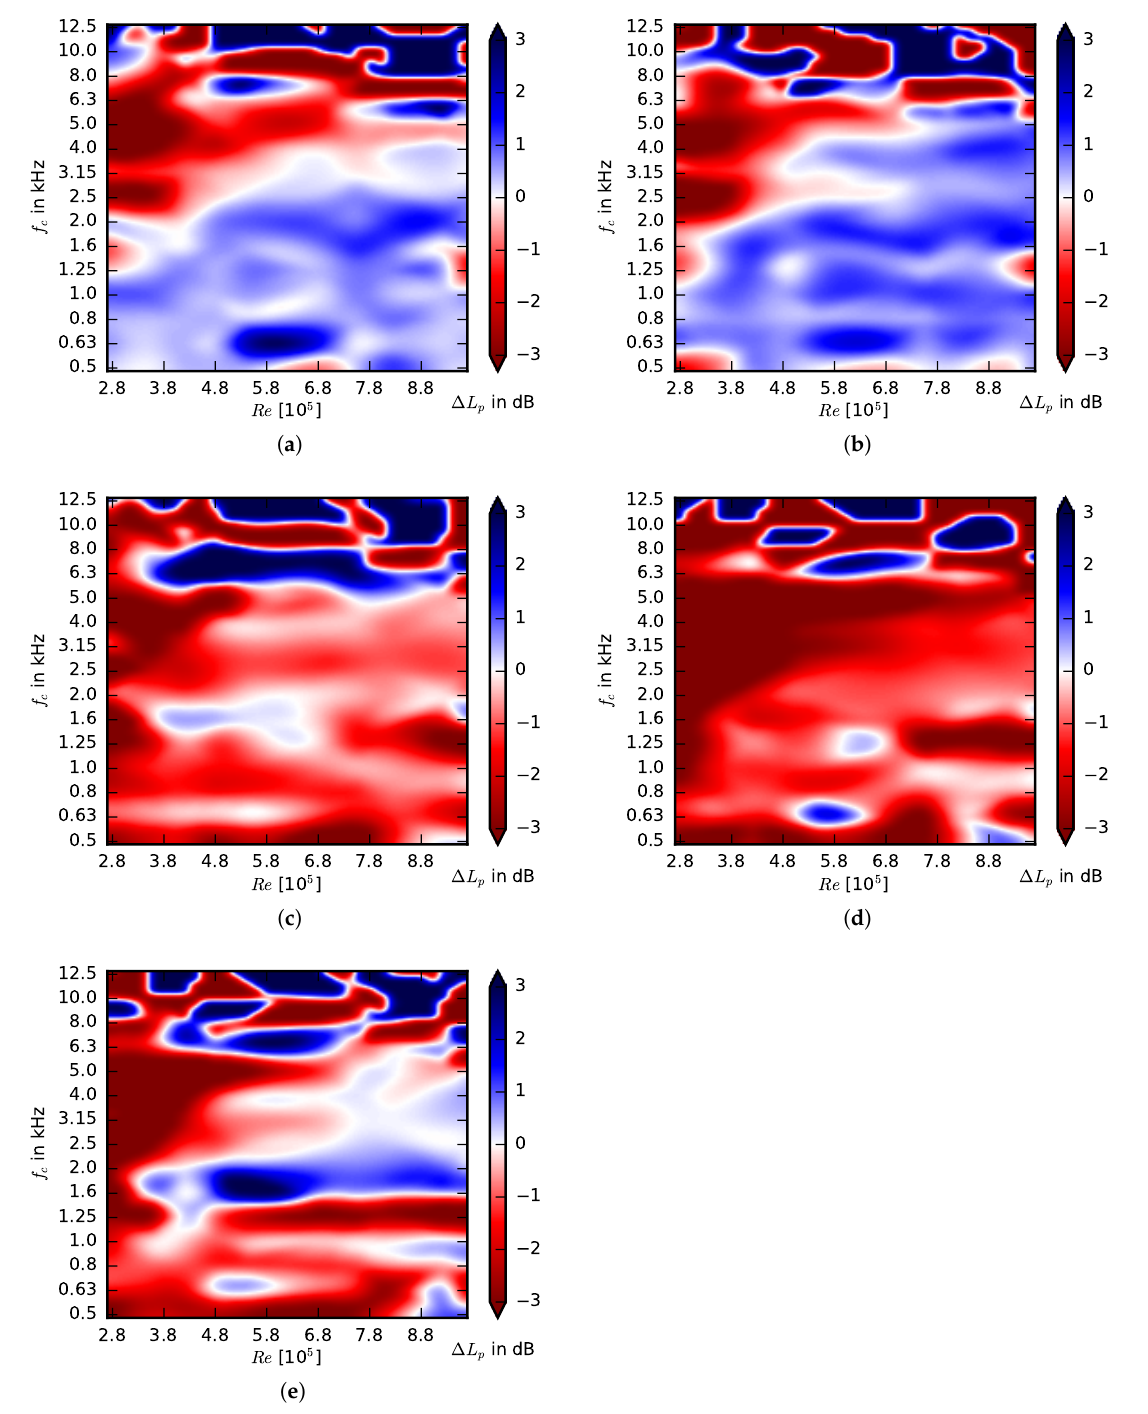
Figure 10. Leading edge sound pressure level difference ∆ L p according to Equation (4) for the airfoils with teeth of h / c l = 0.06, angle of attack 6 ◦ , PPS 12/2 turbulence grid (positive values denote a noise reduction due to the modifications, negative values a noise increase), ( a ) airfoil 2, h / c l = 0.06, s / c l = 0.038, straight, ( b ) airfoil 9, h / c l = 0.06, s / c l = 0.038, curved, ( c ) airfoil 4, h / c l = 0.06, s / c l = 0.019, straight, ( d ) airfoil 10, h / c l = 0.06, s / c l = 0.019, curved, ( e ) airfoil 7, h / c l = 0.06, s / c l = 0.0095,